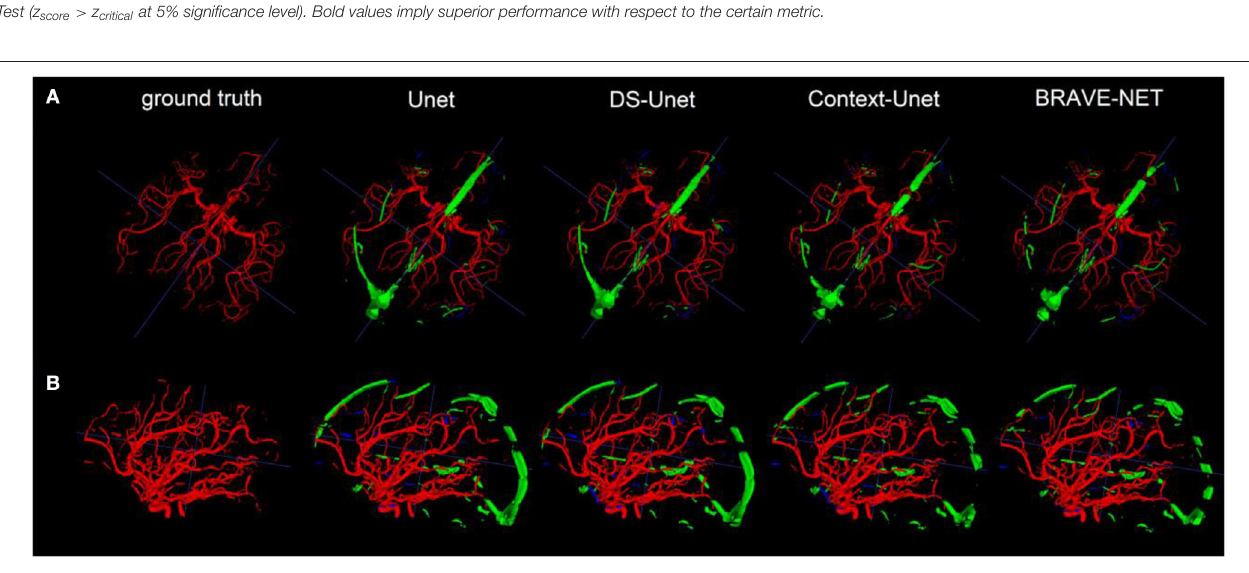
FIGURE 8 | Our result findings were consistently favoring the performance of the BRAVE-NET architecture. One example is shown from two view-points in rows (A,B) . From row (A) the granularity of the close to perfect segmentations, i.e., minimal false negative (blue) voxels—can be observed while row (B) gives a better view on the large falsely segmented sinus (green). These results are not surprising given that the external validation set heavily depicted veins and sinuses next to arteries which were not present in the data used for